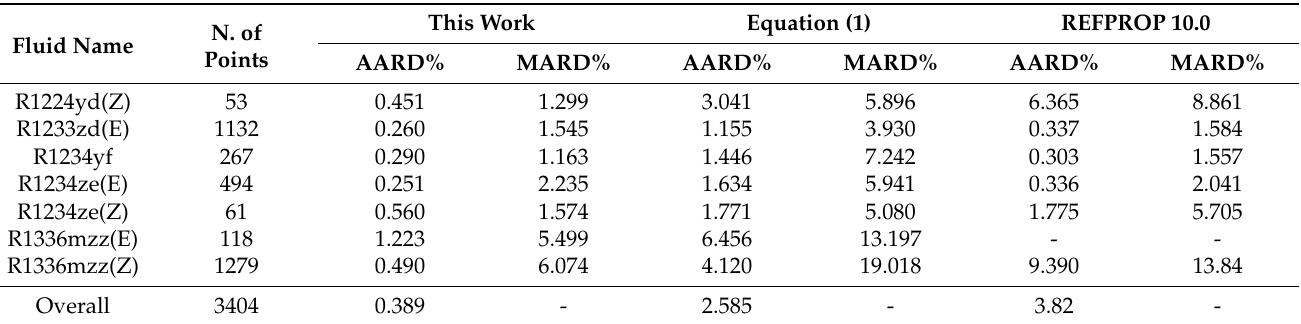
Table 5. Average absolute relative and maximum absolute relative deviations between the exper- imental λ L data of the studied refrigerants and the calculations provided by the proposed neural network, Equation (1) and REFPROP